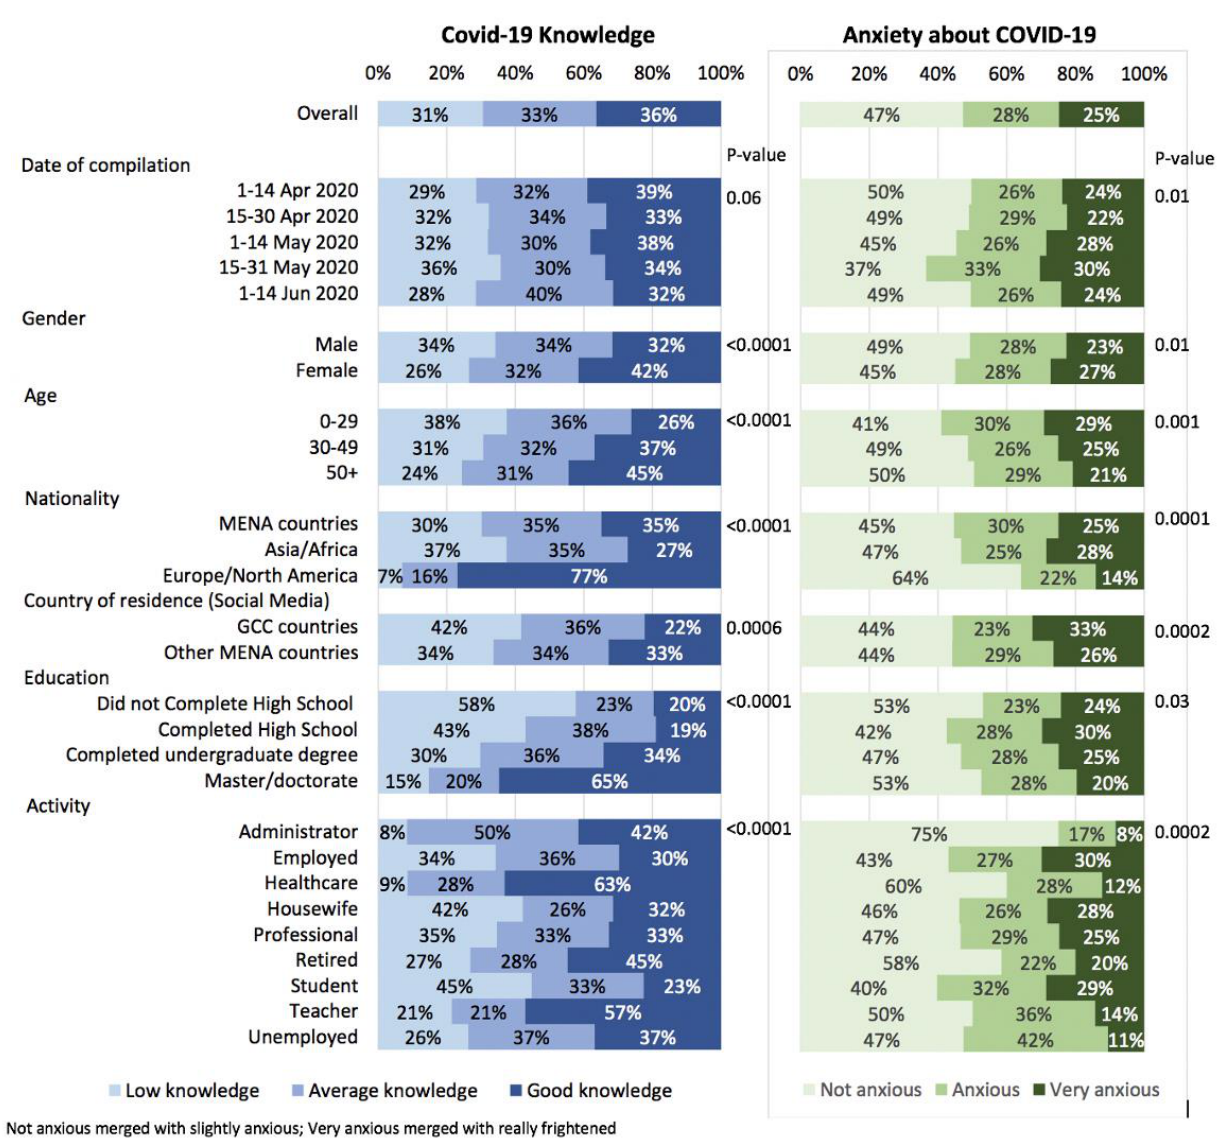
Figure 1. Association between participants’ characteristics, COVID-19, knowledge and anxiety about COVID-19 in 1658 responders to the survey.